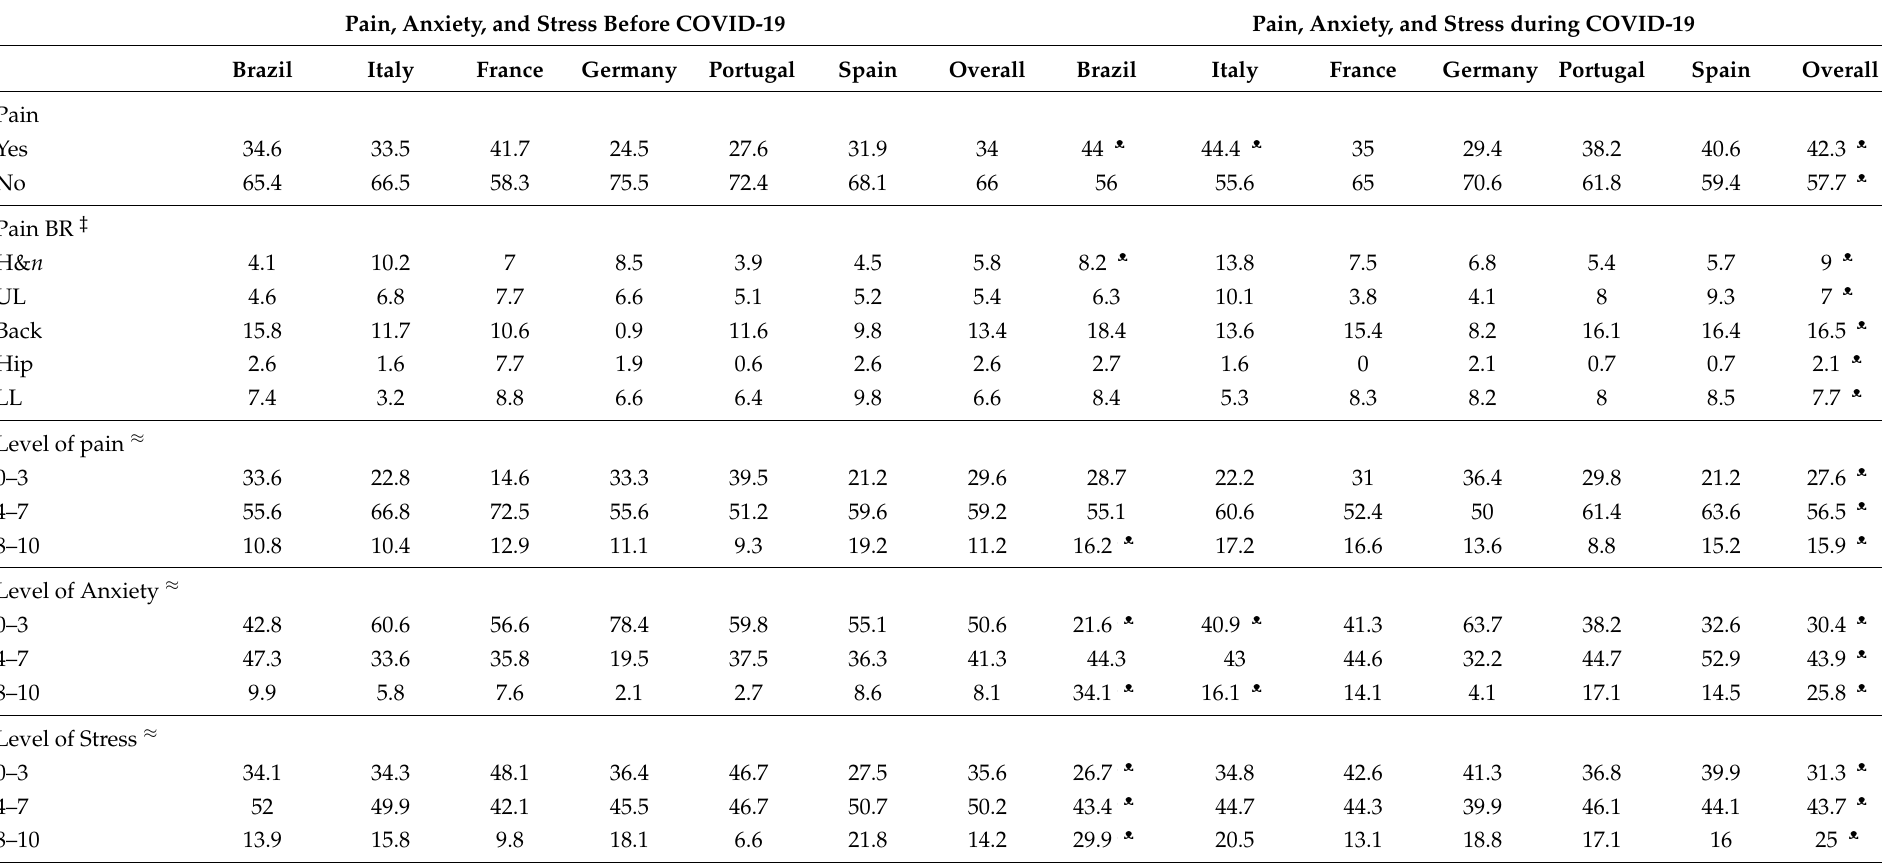
Table 6. Level of pain and psychological impact of the sample from Brazil ( n = 1845), Italy ( n = 680), France ( n = 236), Germany ( n = 143), Portugal ( n = 152) and Spain ( n = 138), aged from 18 years old ( n = 3194), before and during the COVID-19 pandemic. Values are presented as percentages